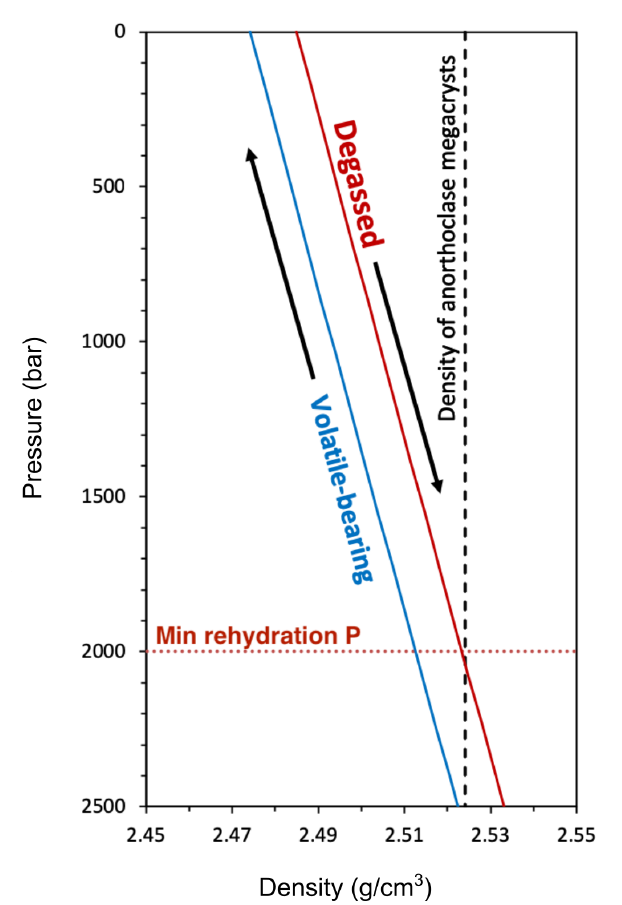
Figure 4: Density-driven convection within the shallow plumbing of Erebus volcano is likely the result of cycles of near-surface degassing followed by deep rehydration of phonolite melts at a minimum pressure of ∼ 2,000 bar (horizontal red dotted line). Low-density volatile- bearing melts (blue curve) rise to the surface where they degas and sink back into a shallow magma stor- age zone (red curve) where they are replenished with volatiles. This cycling is recorded in cyclic chemical zoning within anorthoclase megacrysts (black dashed line) that settle to a maximum depth of ∼ 2,000 bar and are carried upward during pulsatory ascent of hydrated magma